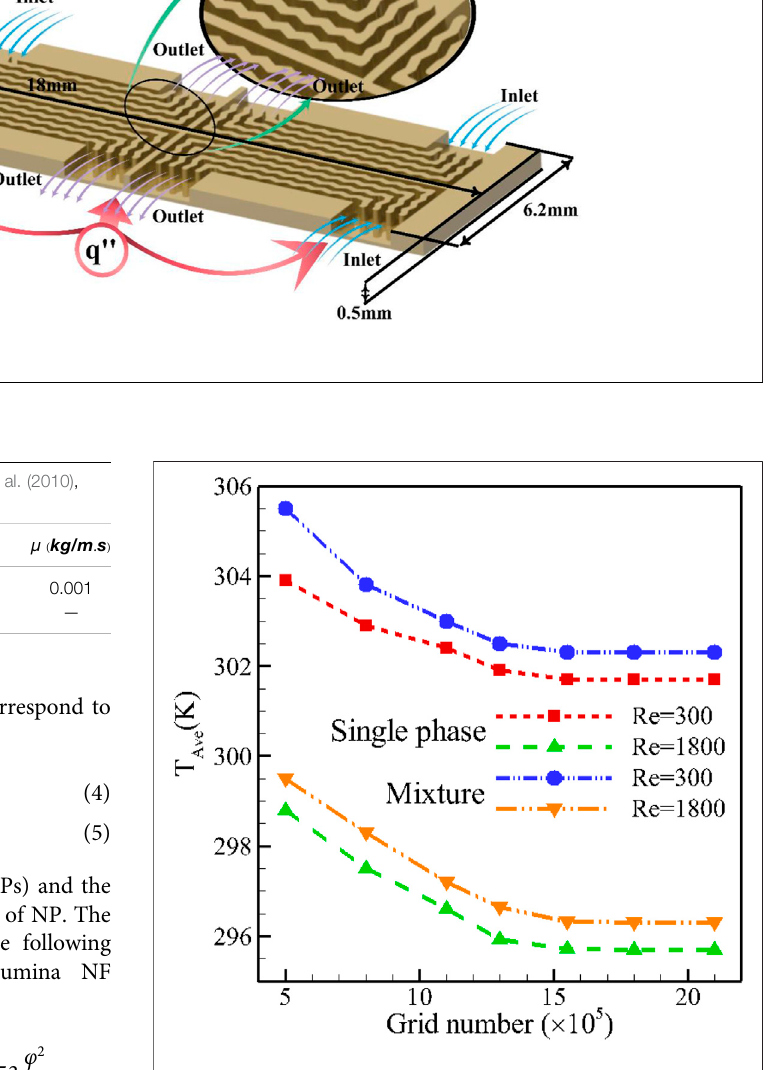
FIGURE 2 | The impact of the number of grid elements on the T Ave of the